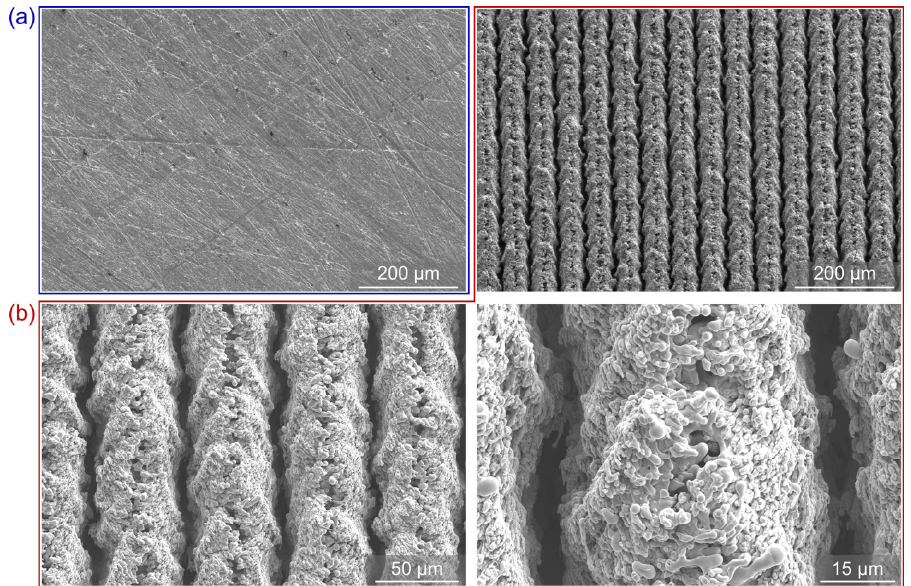
Figure 1. SEM images of the ( a ) untreated reference sample REF (blue frame) and ( b ) laser-textured sample LT (red frame) before exposure to boiling.